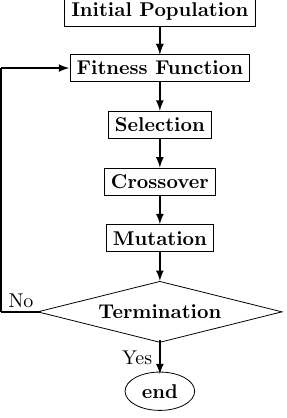
Figure 3. Genetic algorithm scheme.